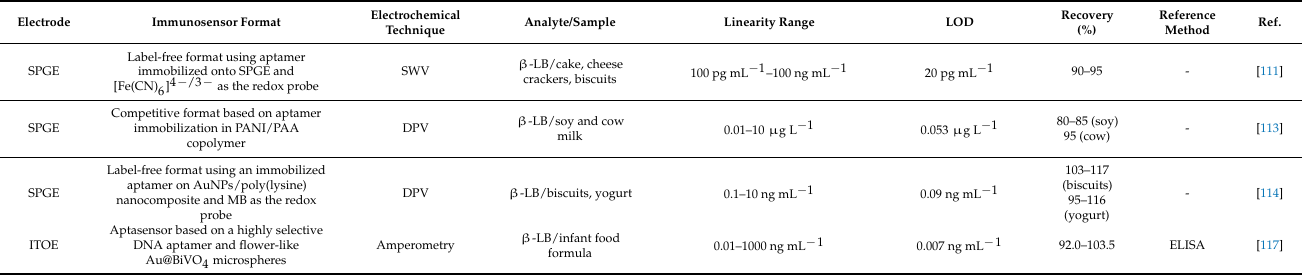
Table 2. Performance of electrochemical aptasensors for allergen detection.